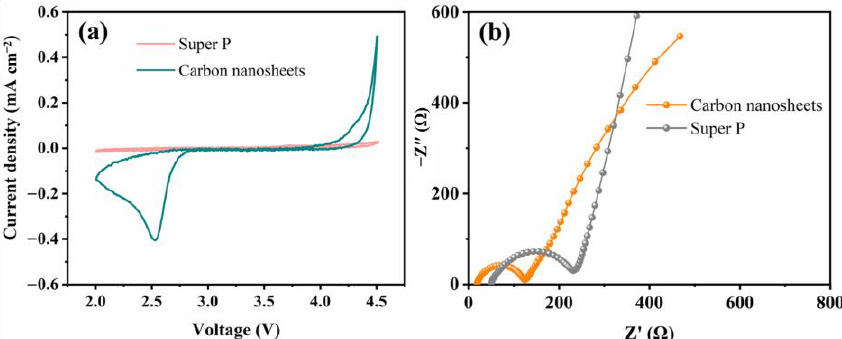
Figure 6. CV curves ( a ) and EIS spectrum ( b ) of carbon nanosheets and Super P catalysts.